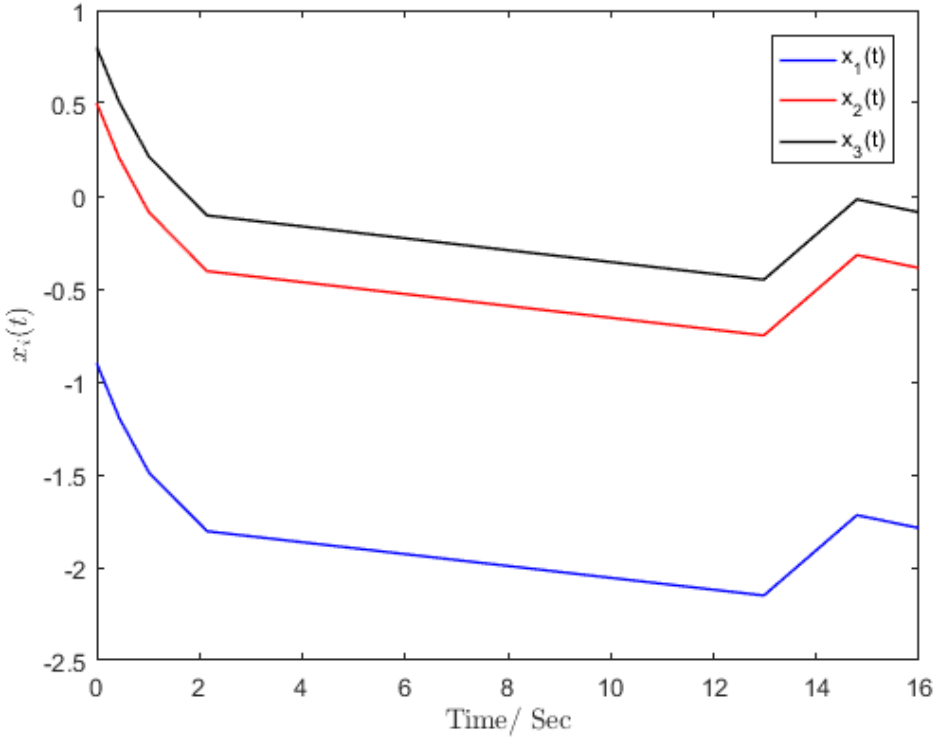
Figure 9. State of the system without